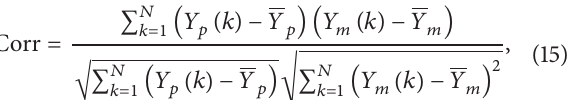
Figure 7: Bode plots of the open-loop actual BLDC motor with controller